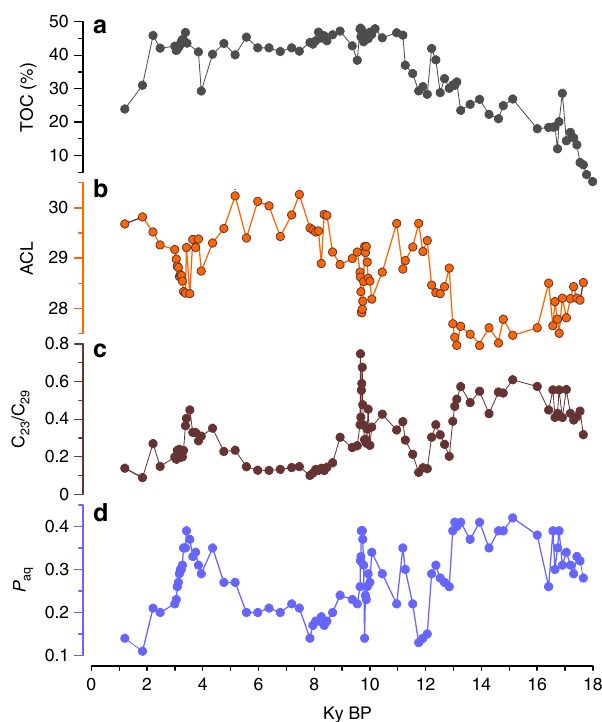
Fig. 3 Variations of TOC and n -alkane ratios in the ZK-5 peat core. a TOC. b ACL. c C 23 /C 29 ratio. d P